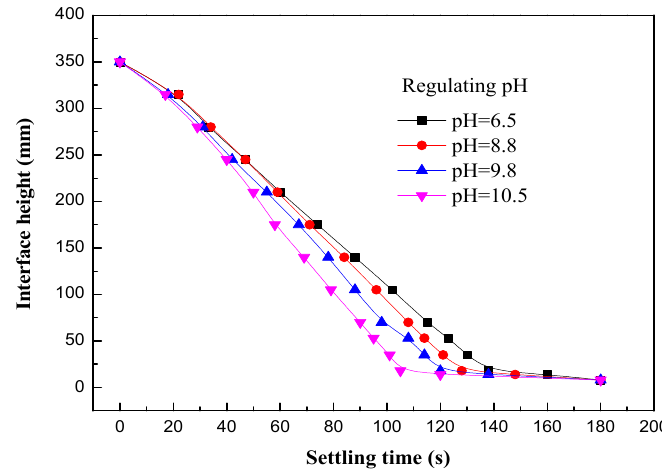
Figure 3. Effect of pH on the sedimentation (APAM: 2 mg/L, regulating time: 5 min, Fe 3+ : 56 mg/L).